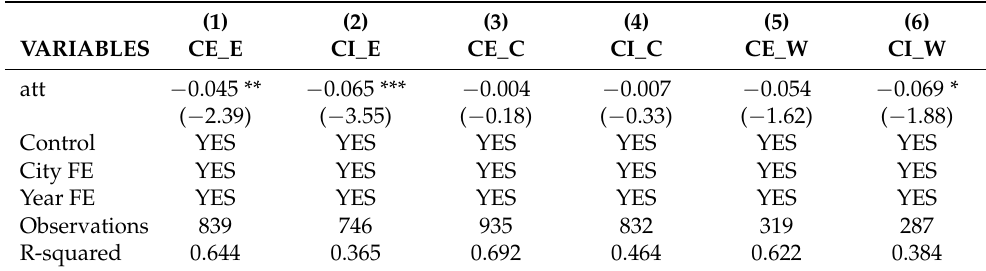
Table 11. Heterogeneity of geographic location test.